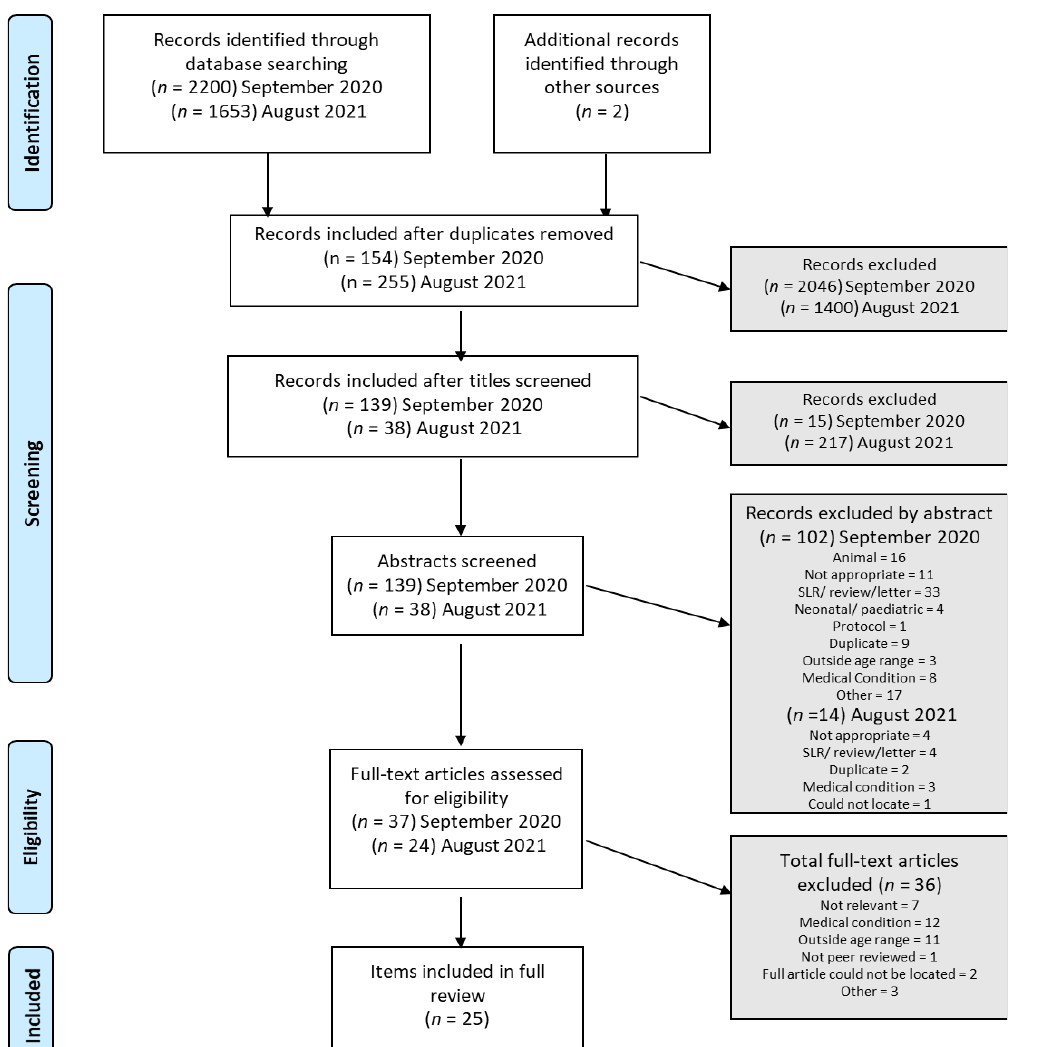
Figure 1. Flow diagram of the study selection process.